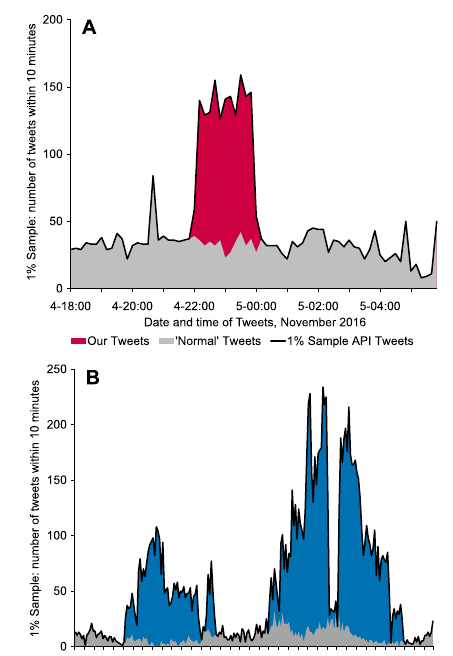
Figure 2 Manipulation experiments—volume. The grey areas represent Tweets in Twitter’s 1% Sample API from all 328 million users, excluding Tweets that were sent from our 100 automated accounts, which were designed to hit the sample time window with high probability. The thick lines are what researchers and analysts see when they study the respective hashtags through the lens of the Sample API. Data shows Tweets per 10 minutes in the 1% Sample API, so that 50 Tweets would be perceived as 5000 on all of Twitter. ( A ) #trump Sample API manipulation experiment. ( B ) #imwithher Tweets per 10